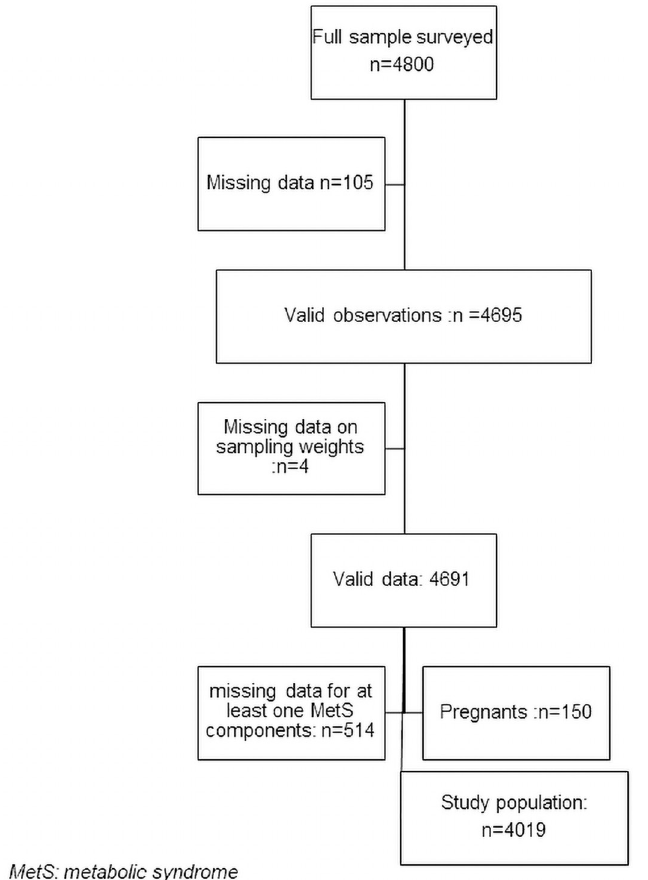
Fig 1. Diagram flow of study